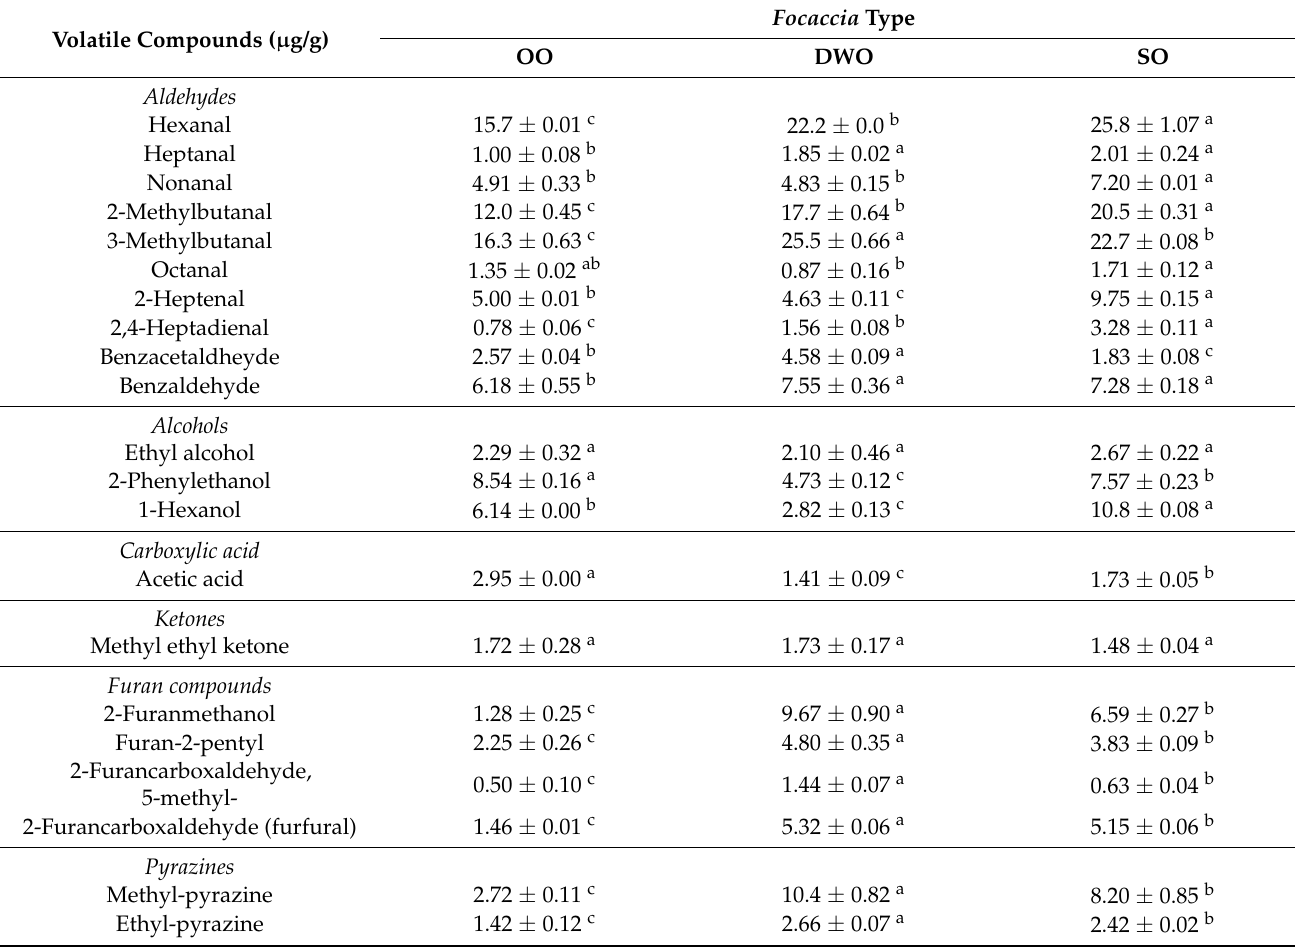
Table 5. Volatile compounds of experimental focaccia . OO = focaccia prepared with olive oil; DWO =